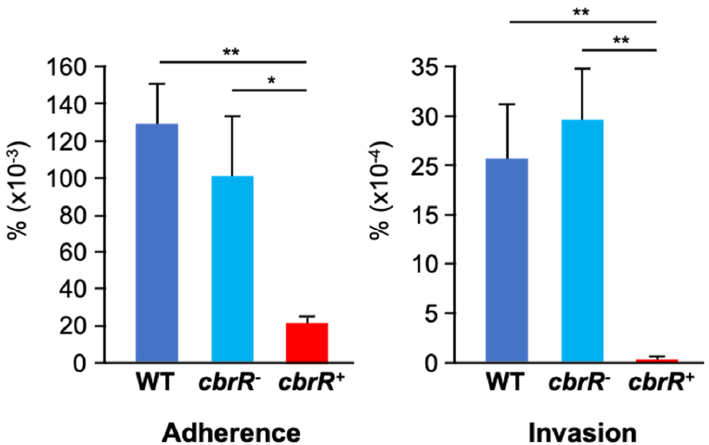
Figure 6. Loss of CbrR expression leads to a defect in host cell adherence and invasion. Assessment of WT, cbr − R , and cbrR + strains to attach and invade host cells was determined by infecting human epithelial INT407 cells with each of the strains. WT and cbrR − cells attached and invaded cells at similar rates, whereas cbrR + cells showed deficiencies in both adherence and invasion compared to both WT and cbrR − (* p < 0.05; ** p < 0.01). Statistical significance was determined by a one-way ANOVA with Tukey’s multiple comparisons test (GraphPad Prism 9, San Diego, CA, USA). Experiments were performed three times in triplicate.